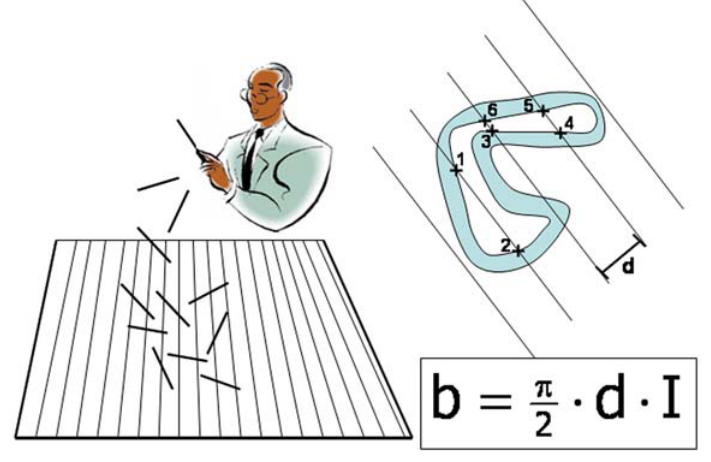
Fig. 7 – Buffon’s needle problem and a practical determination of perimeter (b) based on the knowledge of the line distance (in a test-system) and the number of intersections of the structure boundary with the lines (I).